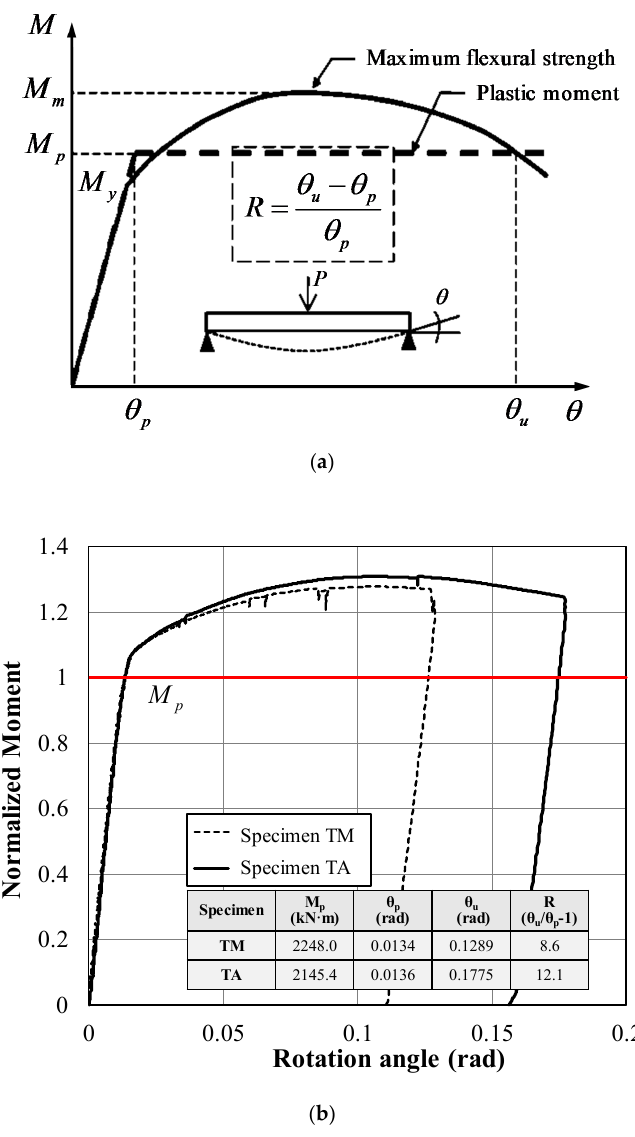
Figure 10. Estimation of rotational capacity. ( a ) Rotational capacity of flexural member; ( b ) normalized moment-rotation angle curve.